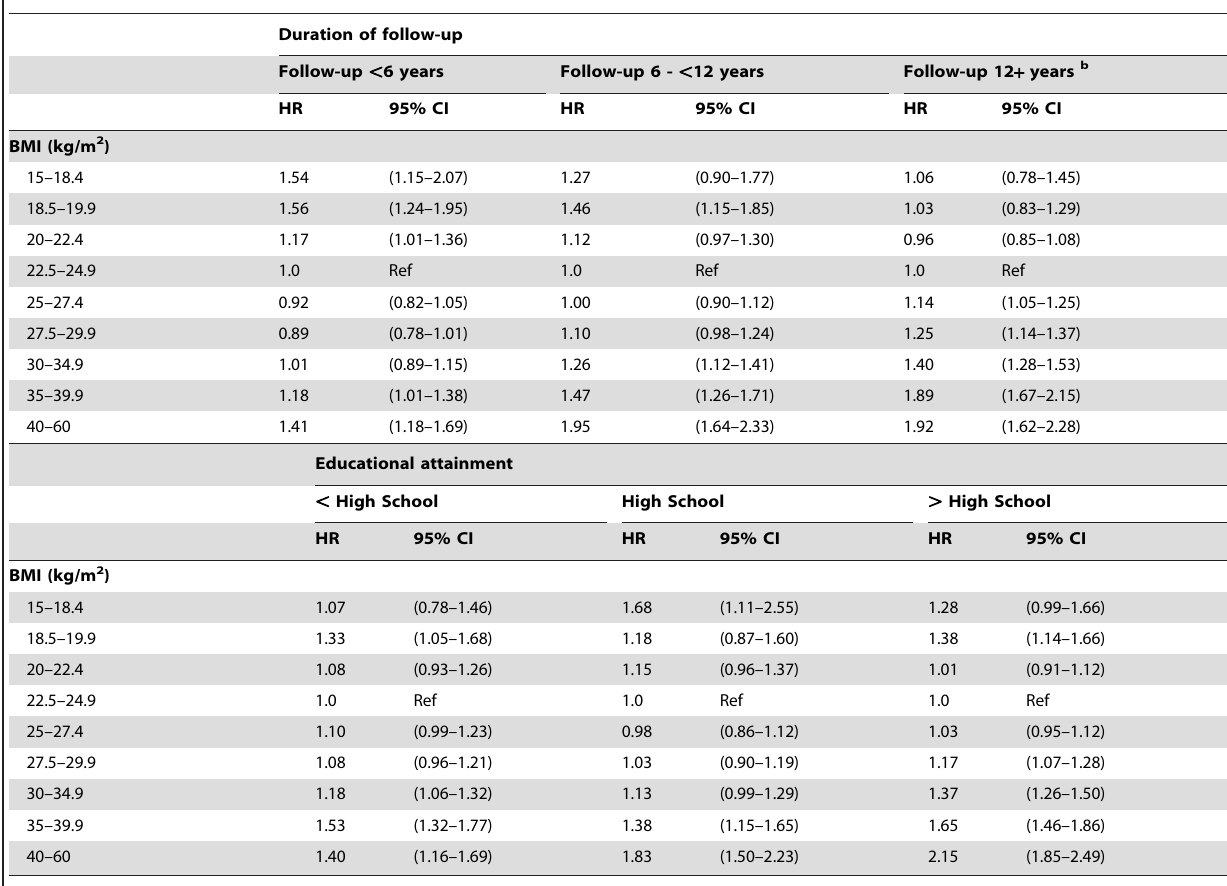
Table 3. Hazard ratios (HR) and 95% confidence intervals (CI) from multivariate Cox proportional hazards models for all-cause mortality according to categories of body mass index among African American participants without chronic illness a at baseline who never smoked, stratified by duration of follow-up and educational